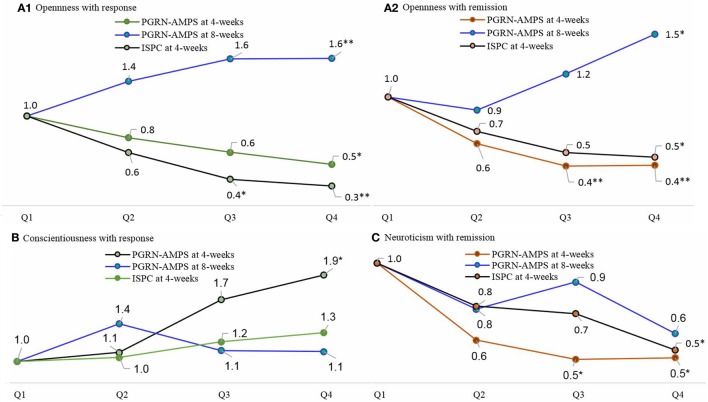
The line plots represent the ORs for favorable response or remission to selective serotonin reuptake inhibitors treatment in patients with MDD with a high personality traits polygenic load (Q2, Q3, and Q4) compared to patients with the lowest polygenic load (Q1), estimated at the most significant p-value thresholds. The quartile-based polygenic scores analyses were performed using data at 4 weeks in the ISPC and at 4 and 8 weeks in the PGRN-AMPS. A polygenic loading for openness personality trait was initially associated with poor response and remission to selective serotonin reuptake inhibitors (SSRIs) in the first 4 weeks of treatment (ISPC, PGRN-AMPS at 4 weeks). After a longer (8 weeks) treatment follow-up, the genetic loading for openness had shown a favorable effect to SSRIs response and remission (PGRN-AMPS at 8 weeks). The polygenic loading for conscientiousness personality was favorably associated with response to SSRIs treatment. However, a polygenic loading for neuroticism personality had shown a negative impact on SSRIs remission. The ORs are reported on the lines and the *sign indicates the statistical significance of the ORs as *p < 0.05, **p < 0.01, ***p < 0.001. Abbreviations: PGRN-AMPS, the Pharmacogenomics Research Network Antidepressant Medication Pharmacogenomic Study; ISPC, the International SSRI Pharmacogenomics Consortium study. OR, odds ratio; Q1, quartiles 1; Q2, quartiles 2; Q3, quartiles 3; Q4, quartiles 4; MDD, major depressive disorder.